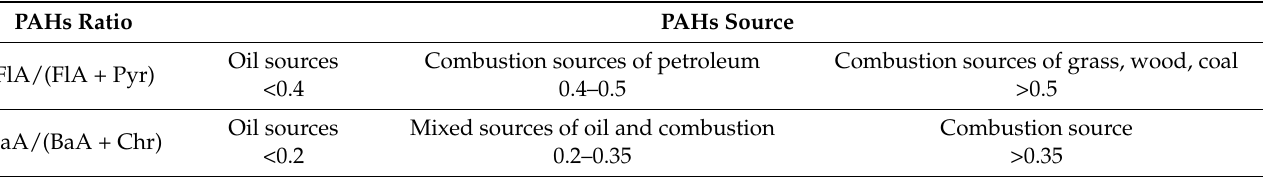
Table 1. Standard for determining the sources of PAHs by isomer ratio method. PAHs Ratio PAHs Source Oil sources Combustion sources of petroleum Combustion sources of grass, wood, coal FlA/(FlA + Pyr) <0.4 0.4–0.5 >0.5 Oil sources Mixed sources of oil and combustion Combustion source BaA/(BaA + Chr) <0.2 0.2–0.35